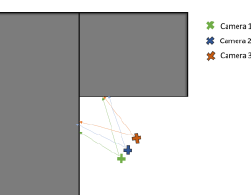
Figure 3 Cameras of neighbouring facades (green, red) tilted to look at the inner